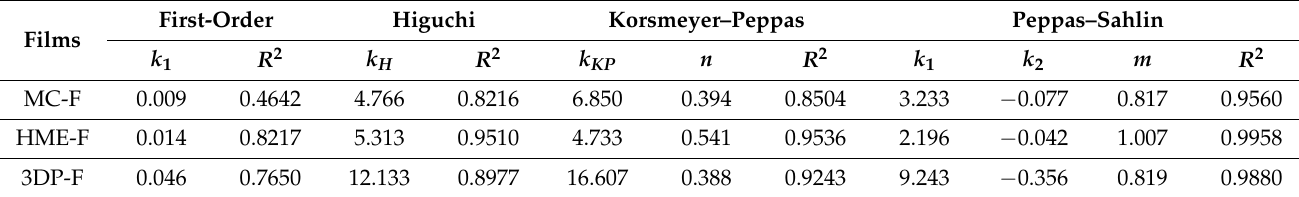
Table 2. The model fitting parameters of the dissolution study in